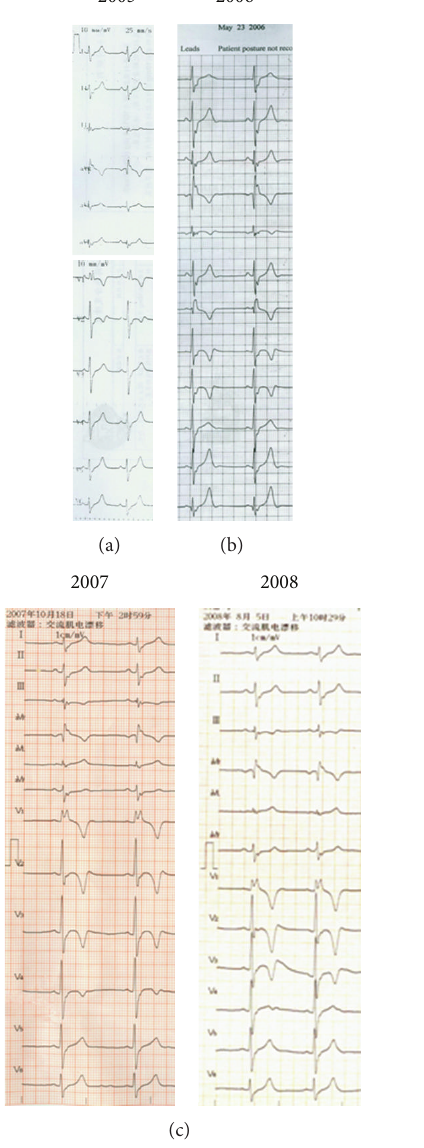
Figure 2: T-wave progression on ECG and (a) T-wave inversion in leads V1, V2 in 2005; (b) T-wave inversion in leads V1 ∼ V3 in 2006; (c) T-wave inversion in leads V1 ∼ V4 in 2007 and 2008.